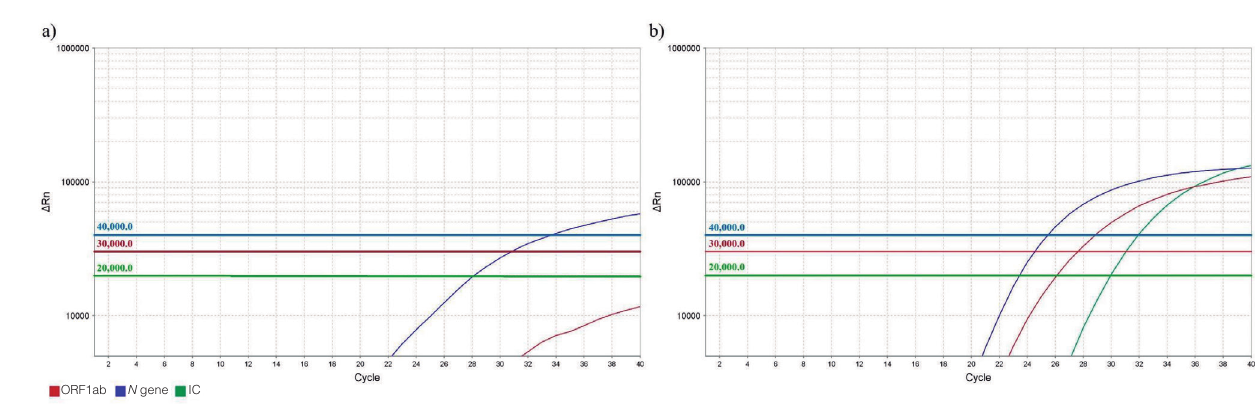
FIGURE 2 – Differences in amplification patterns of a sample with inhibitors before (a) and after (b)